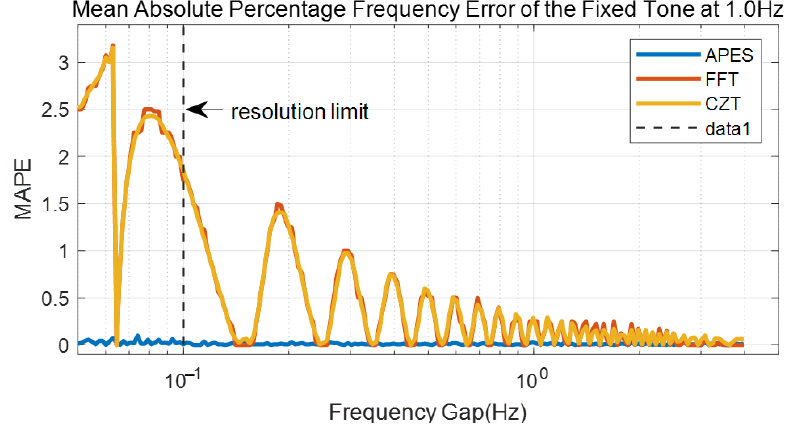
Figure 3. Double-tone frequency estimation error vs. different frequency position. The blue solid curve, the red solid curve, and the yellow dash curve are the results obtained by APES, FFT, and CZT, respectively.